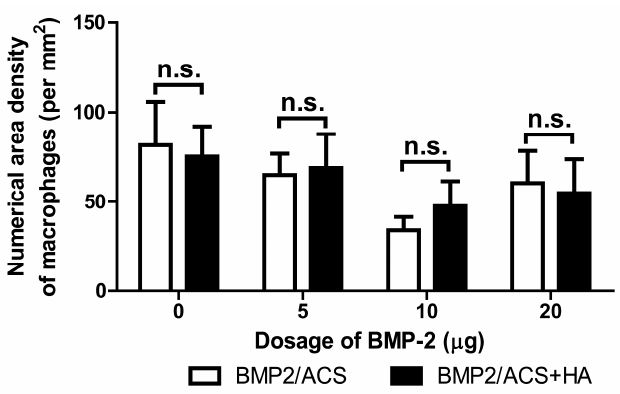
Figure 5. Mean values of the numerical area densities of macrophage cell profiles in the BMP-2/ACS constructs, in the presence or absence of 100 μ g/mL HA (48 kDa) implanted at different BMP-2 dosages, 18 days after implant placement. Values represent means ± SEM; n = 6 per experimental group. n.s.: denotes absence of significant differences ( p > 0.05). The compared groups are indicated by brackets.